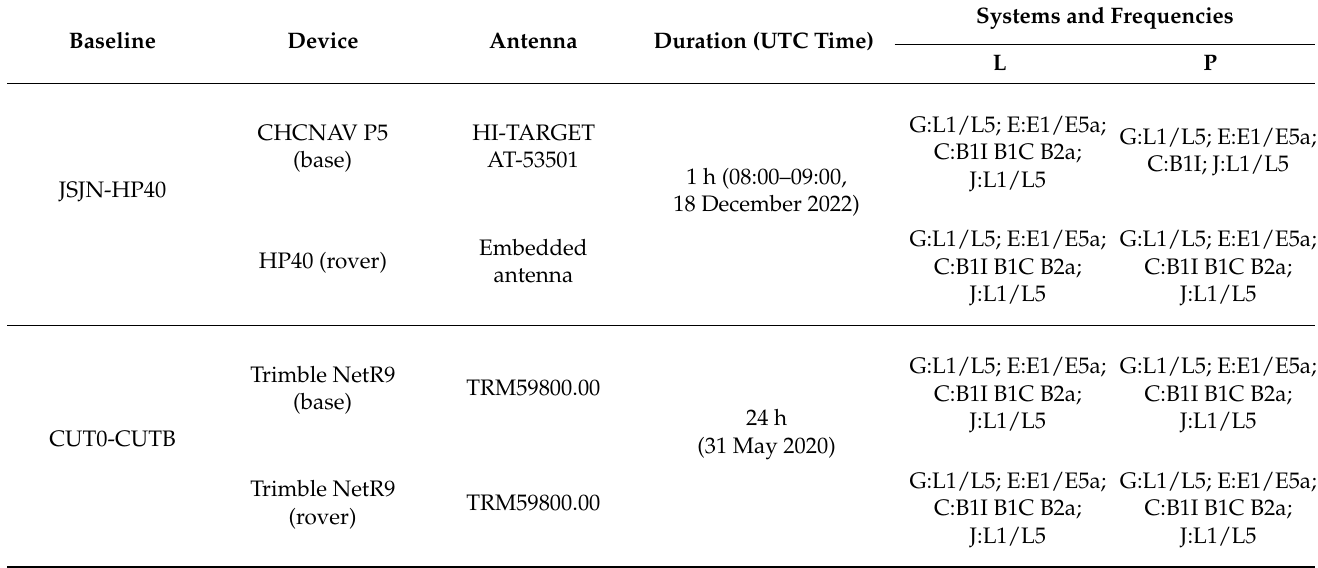
Table 1. The information and details of static